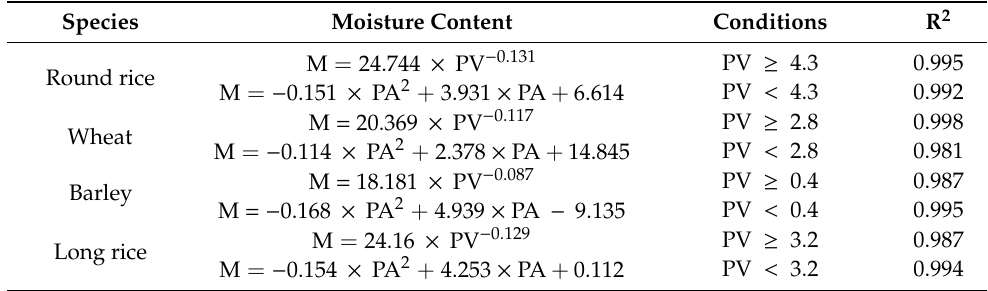
Table 2. Functions for calculating moisture content of four kinds of grains. Notes: PV and PA are the peak value and peak area, respectively. The reference temperature was 25 ◦